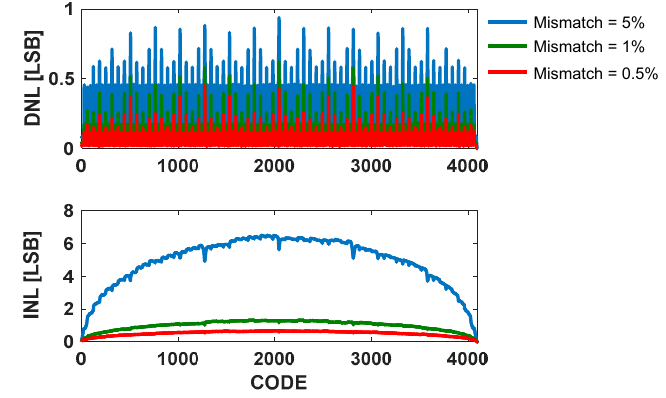
Figure 13. CDAC Mismatch Simulation.